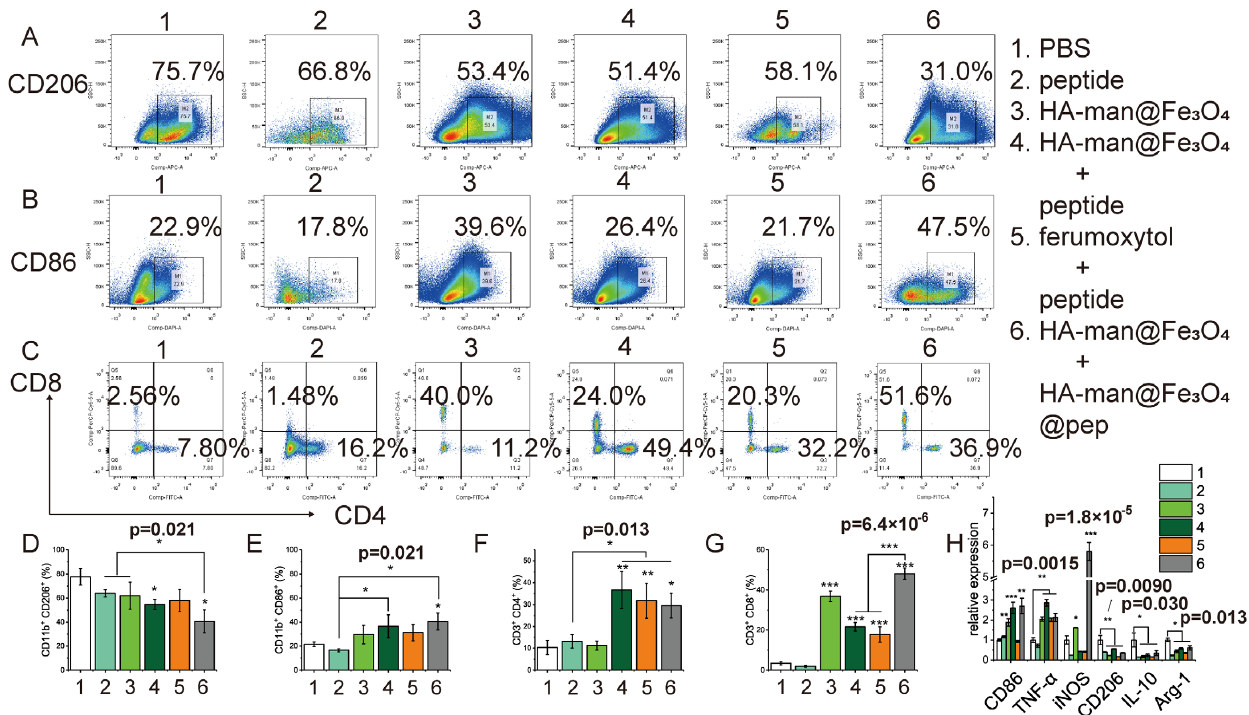
Figure 7. Flow cytometry and qPCR analysis of tumor tissue 24 h posttreatment. ( A , D ) CD206 expression by TAMs; ( B , E ) CD86 expression by TAMs; ( C , F , G ) CD4 and CD8 expression by T cells in tumor tissue; ( H ) TAM polarization-associated gene expressions of tumor tissue. Error bars indicate at least three independent experiments. p -value has been calculated by the one-way ANOVA test. * p < 0.05, ** p < 0.01, and *** p < 0.001.